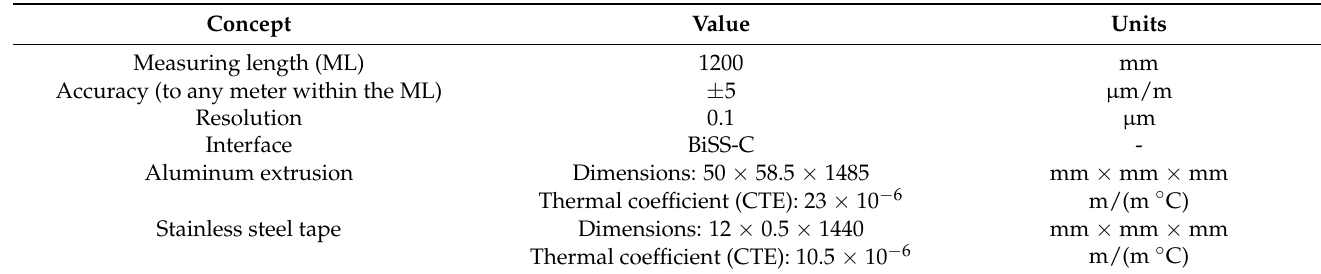
Table 1. Parameters of tested optical linear encoder.